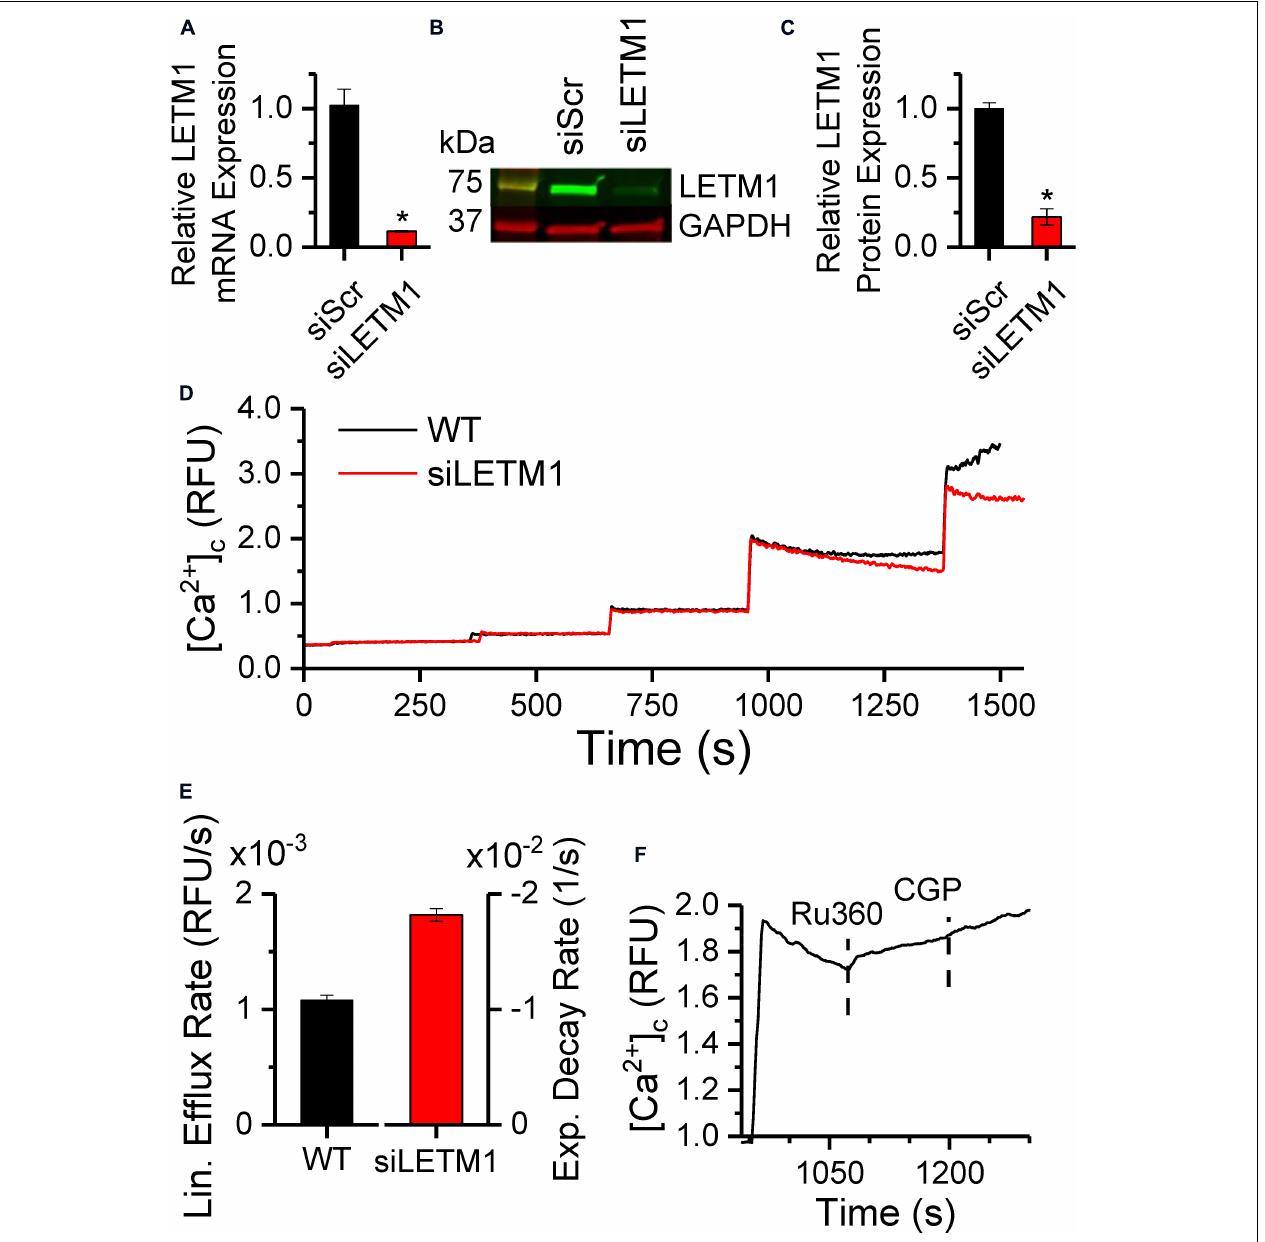
FIGURE 8 | LETM1 knockdown modulates Ca 2 + efflux in permeabilized H9c2 cells. (A) mRNA expression of LETM1 in H9c2 cells transiently transfected with scrambled (siScr) or LETM1 siRNA (siLETM1) for 48 h, normalized to the GAPDH mRNA level. (B) Representative immunoblot and (C) densitometric quantification of LETM1 protein expression in H9c2 cells treated with scrambled or LETM1 siRNA for 48 h, with GAPDH as loading control. Bars in (A,C) represent mean ± SEM ( n = 3) relative to scrambled siRNA. * p < 0.0005 versus. control siRNA. (D) Changes in cytosolic Ca 2 + in permeabilized WT H9c2 cells (black) or H9c2 cells transfected with LETM1 siRNAs (red), in response to 5 µ M CaCl 2 boluses when energized with 10 mM K-Succinate. (E) Rate of change of Ca 2 + calculated using linear fits for Ca 2 + efflux rate in WT and 1-exponential fits for the decay rate in [Ca 2 + ] c in siLETM1 H9c2 cells following the 4th CaCl 2 bolus in (D) . Further